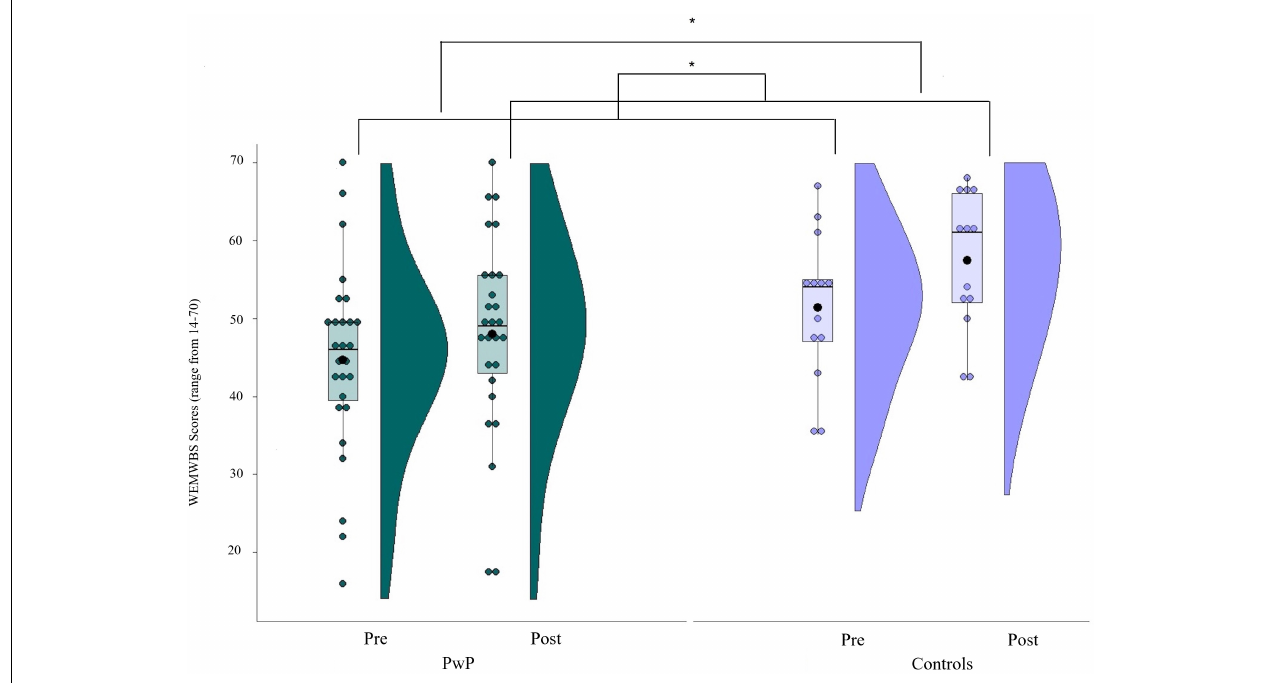
FIGURE 3 | Mean values of the wellbeing (WEMWBS). Scores on a scale from 14 (lower wellbeing) to 70 (higher wellbeing); Solid line = median; Black dot = mean; Whiskers: upper whisker = min(max(x), Q_3 + 1.5*IQR); lower whisker = max(min(x),